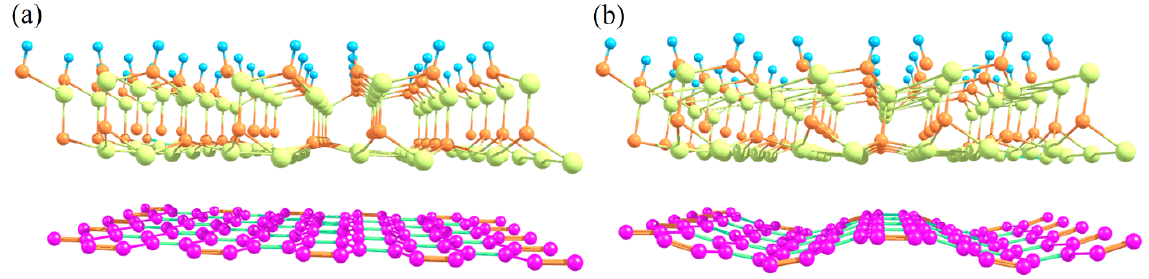
Figure 8. Periodic cell of the AlN–graphene heterostructure ( a ). Rippling of graphene under com- pression applied to the system ( b ). Purple, yellow, orange and blue balls represent C, Al, Ga and H atoms, respectively. Table 1. Interaction energy of AlN surface with pristine, strained and defected graphene calculated with the density functional theory.